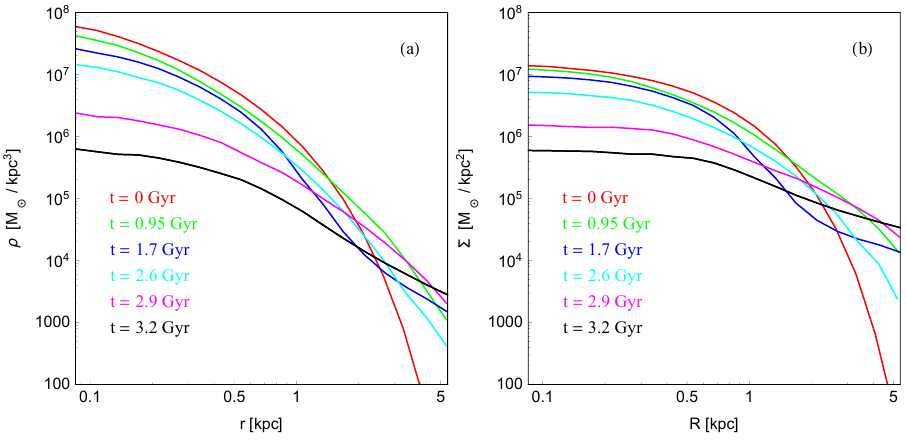
Figure 3. Density profiles of stars in the dwarf at different times. ( a ) The 3D density profiles; ( b ) Surface density profiles in projection onto the orbital plane. The black curve in each panel corresponds to the time of disruption, t = 3.2